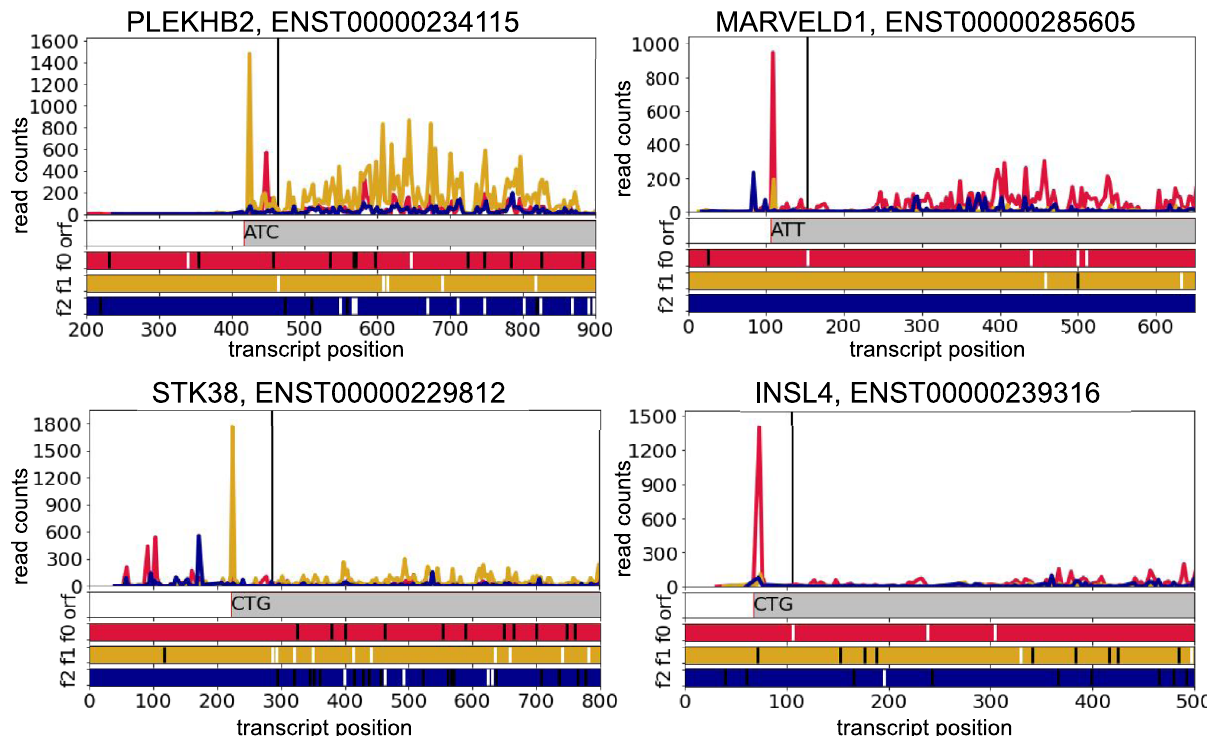
Fig. 5 | Subcodon Ribo-seq pro fi les with the densities of ribosome footprints differentially coloured based on the supported reading frame for examples of predicted genes with exclusive non-AUG initiation ( STK38 , MARVELD1 , PLEKHB2 and INSL4 ). The colours are matched to the reading frames in the ORF plot at the bottom where AUG codons are depicted as white and stop codons as